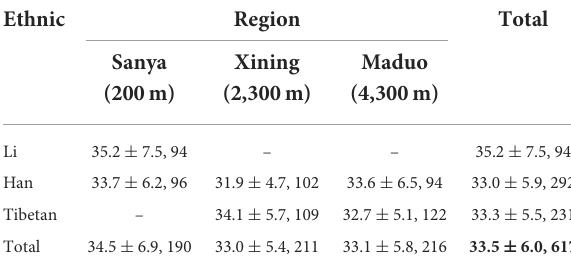
TABLE 3 Age distribution of the enrolled population ( x ± s , n